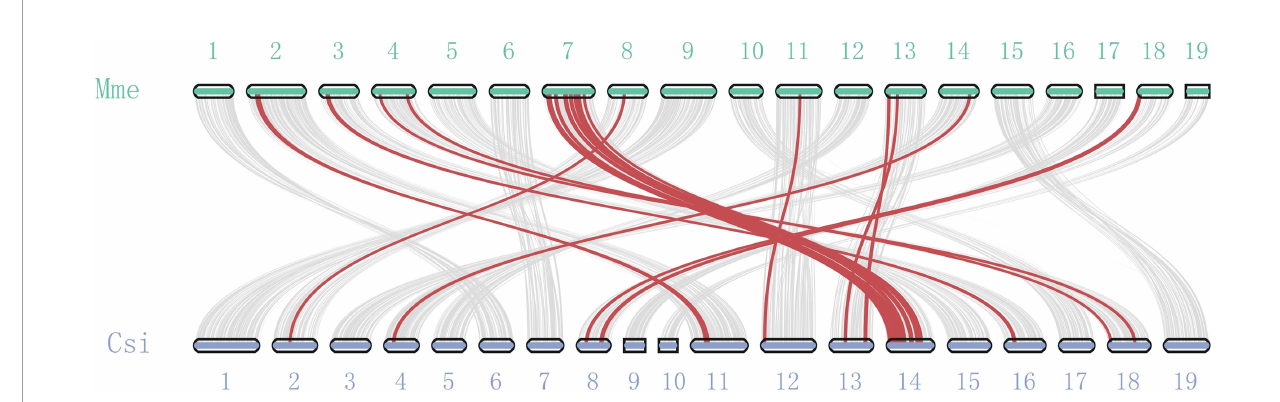
FIGURE 6 | Synteny analyses between the HSP70 genes of the M. mercenaria and C. sinensis . Grey lines in the background indicate collinear blocks in the M. mercenaria and C. sinensis genomes, while red lines highlight syntenic HSP70 gene